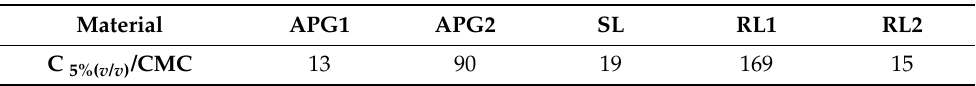
Table 1. Ratios among the effective concentrations of the five surfactants at 5% ( v / v ) and CMC.